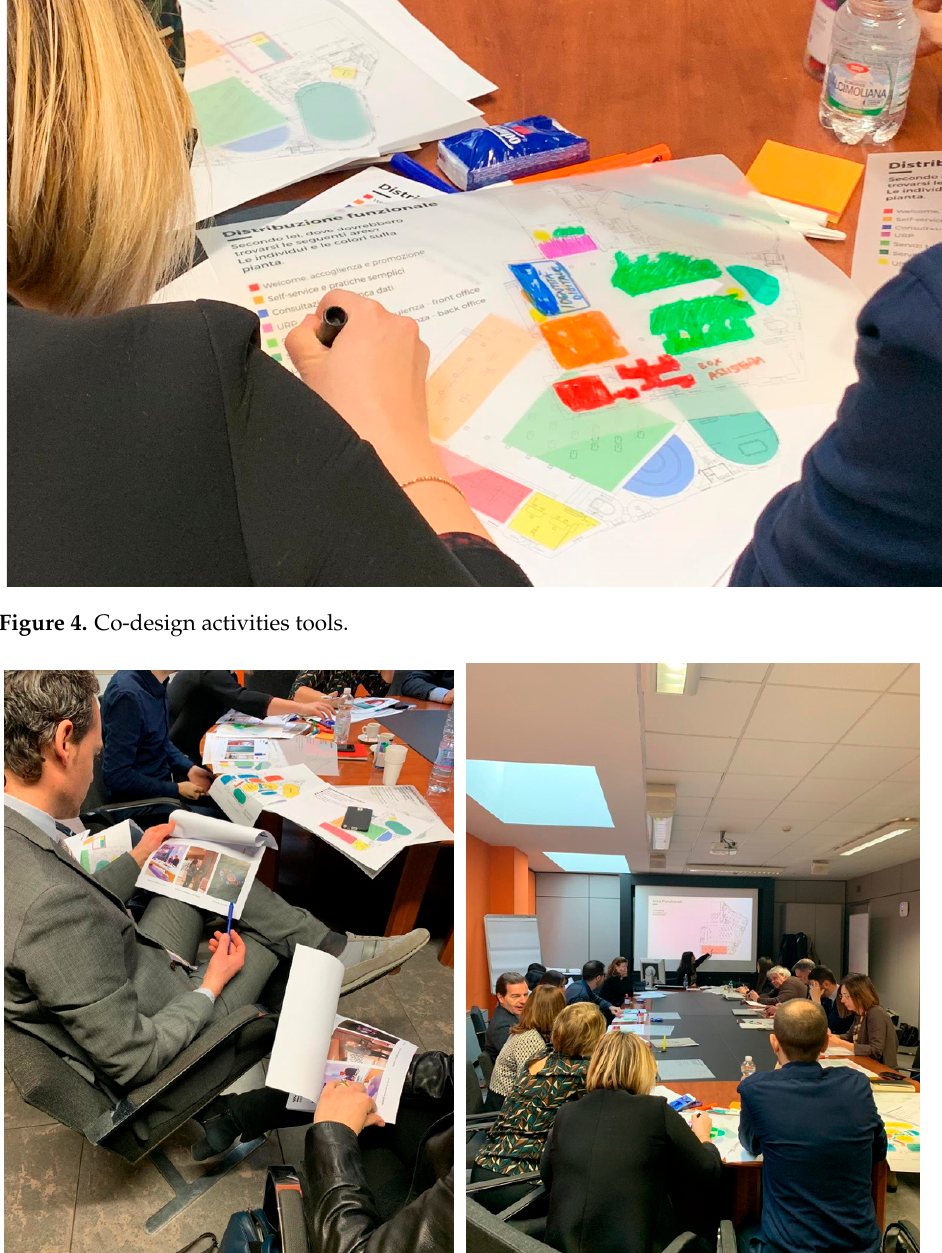
Figure 5. Co-design sessions with designers, architects, managers, government officials, members of the press and service administrators.